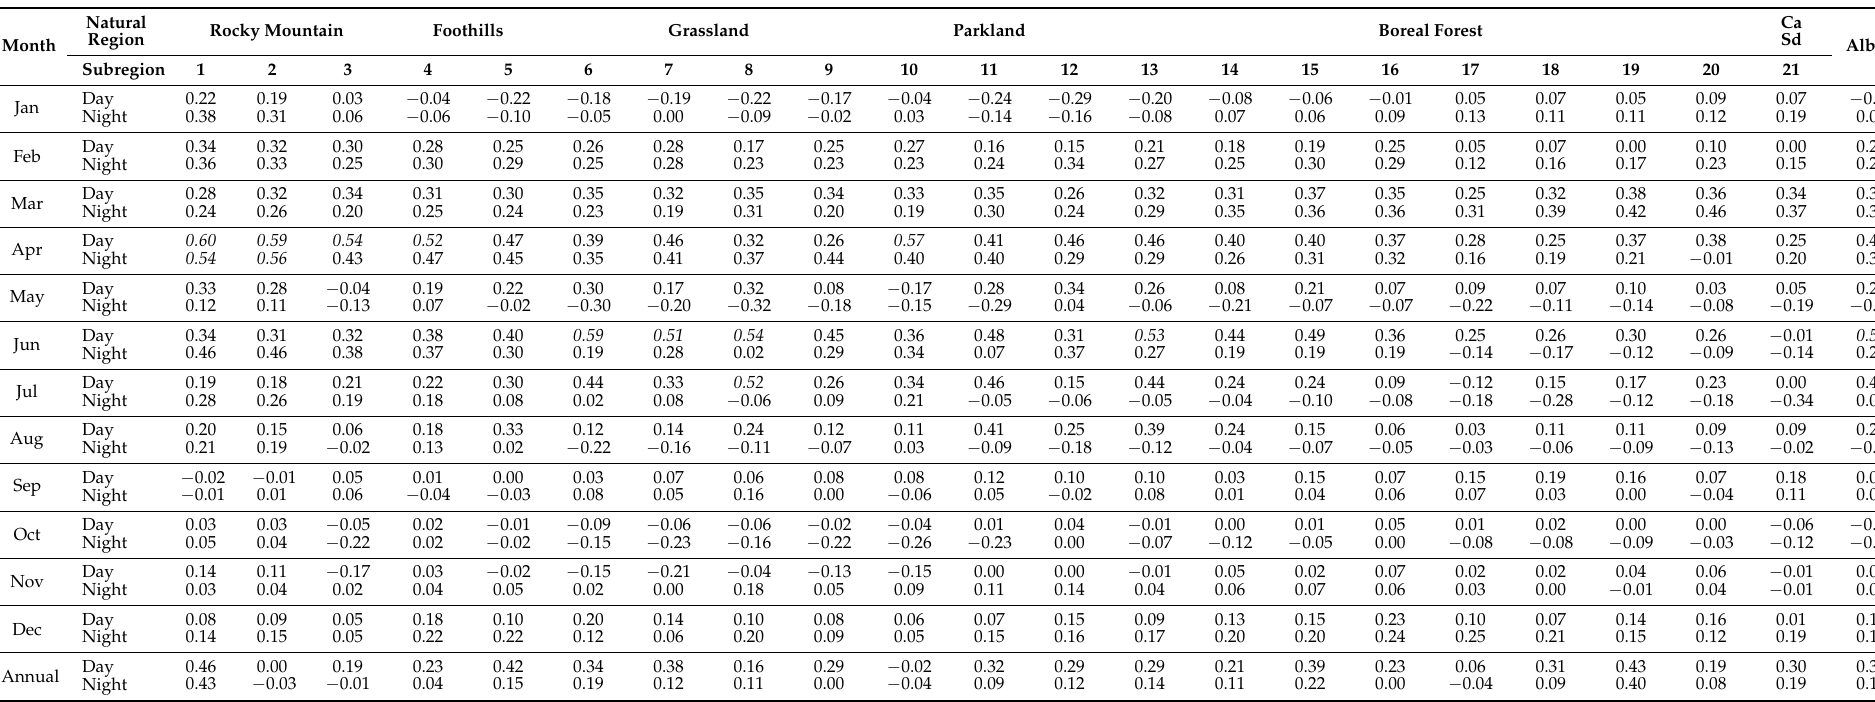
Table 7. Relations between day and nighttime LST and SST (Niño 3.4) indices at both monthly and annual timescales, where acceptable correlations ( r ≥ 0.50) are highlighted